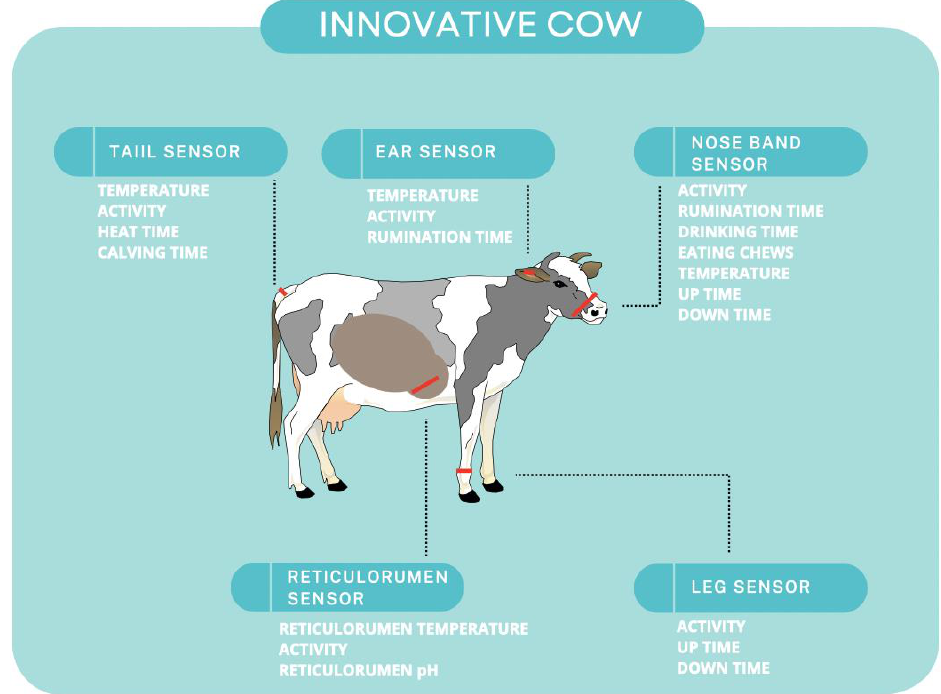
Figure 1. Innovative technologies applied to cows.